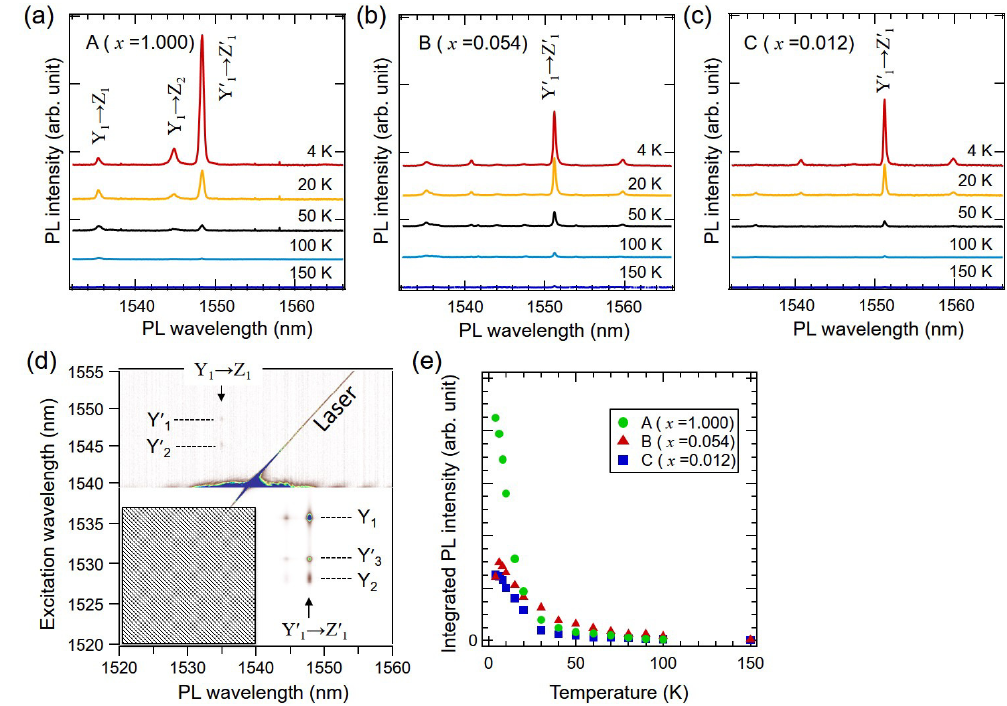
Figure 4. Time-integrated photoluminescence (TI-PL) spectra at different temperatures for the (Er x Sc 1 − x ) 2 O 3 crystals ( a ) Sample A ( x = 1.000), ( b ) Sample B ( x = 0.054), and ( c ) Sample C ( x = 0.012) − Z (cid:48) under the Y (cid:48) resonant excitation with P exc = 1 mW. ( d ) The 2D plot of PLE spectra where the 3 1 excitation laser was swept around the 4 I 13/2 manifold in Sample A at 4 K. In the excitation region of 1520–1540 nm, the PLs below 1540 nm as depicted by a gray square are blocked by a low-pass filter. ( e ) The temperature dependence of the TI-PL intensities of the Y (cid:48) plotted: Samples A (circles), B (triangles), and C